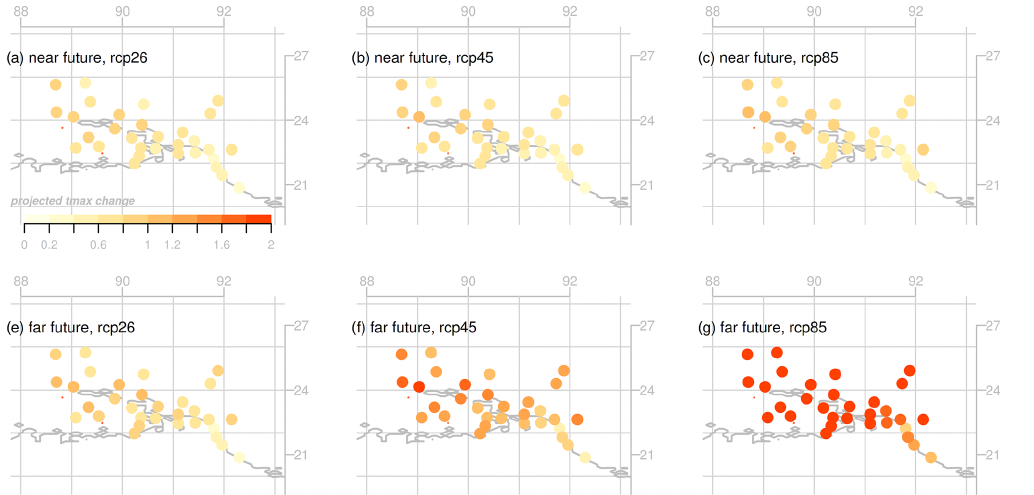
Figure 8. Ensemble mean of the downscaled projections of the maximum temperature in the pre-monsoon season (March–May) for sta- tions in Bangladesh. The panels show the projected change in maximum temperature from the reference period (1981–2010) to the near future (2021–2050, shown in a–c ) and far future (2071–2100, shown in d–f ) assuming emission scenarios RCP2.6 (a, e) , RCP4.5 (b, f) , and RCP8.5 (c, g) . The range of the color scale (0– + 2 ◦ C) does not span the full range of projected temperature changes for the far future assuming RCP8.5 (see Tables 1 and